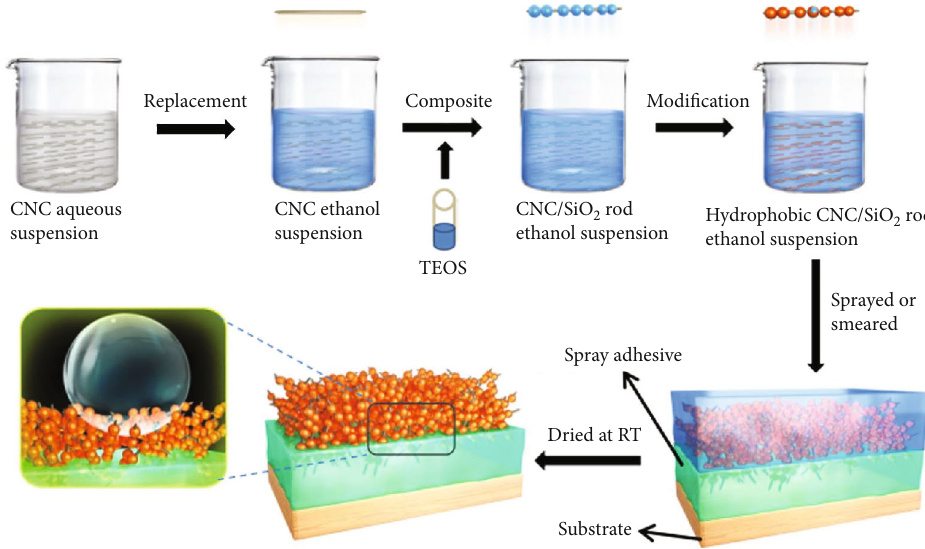
Figure 6: Schematic of preparing CNC/SiO